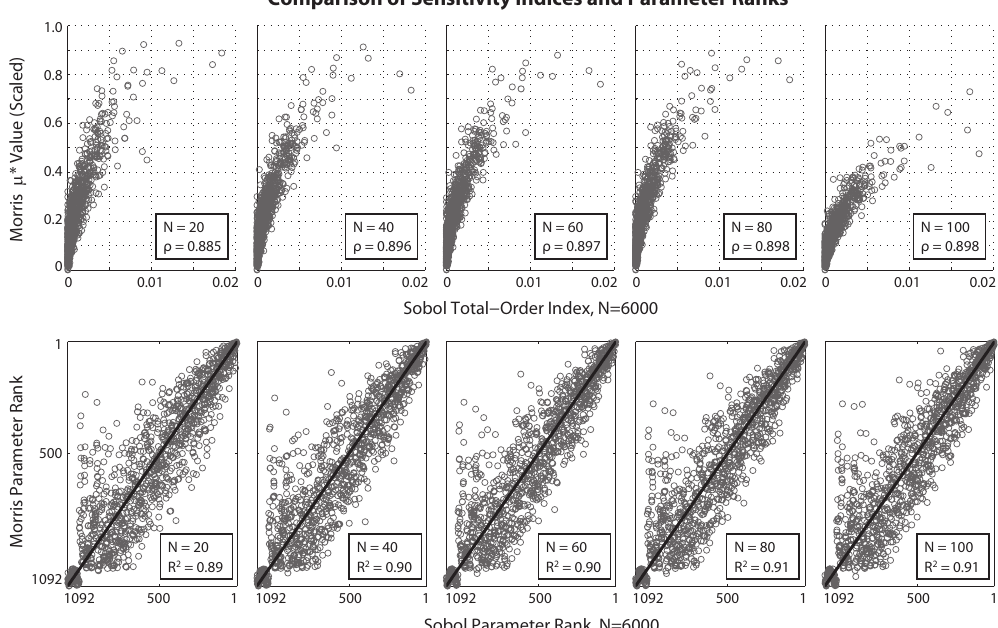
Fig. 5. Statistical comparison of sensitivity indices and sensitivity ranks (1–1092) between the Sobol 0 method ( N =6000) and the method of Morris with sample sizes from N =20 to N =100. The sensitivity indices are compared using a nonlinear Spearman correlation coefficient ( ρ ), while the rankings are compared with a linear correlation coefficient ( R 2 ). Each plot contains all 14 parameters from each grid cell, for a total of 1092 points.